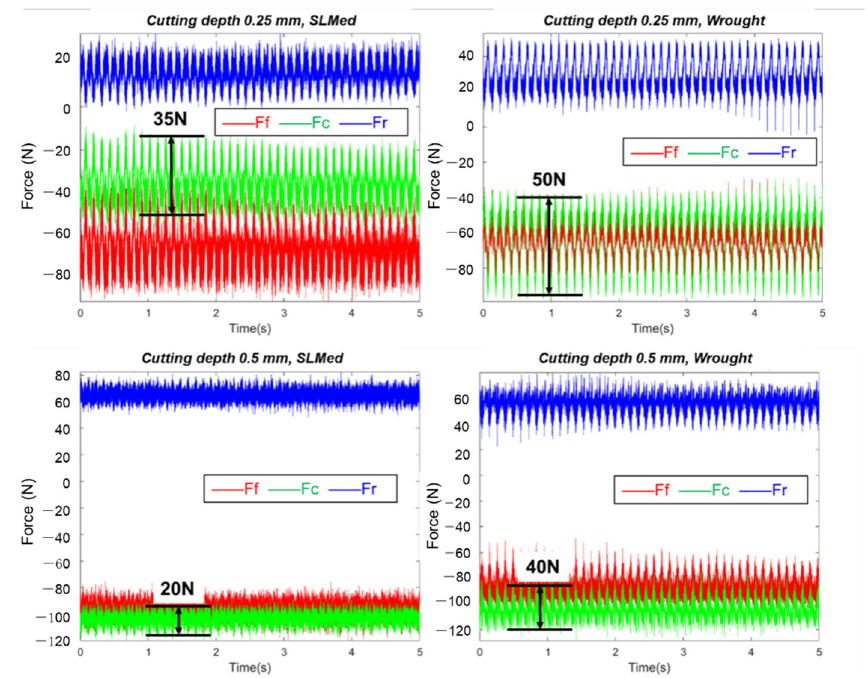
Figure 3. Cutting forces when machining wrought and SLMed Ti6Al4V workpieces at the cutting parameters of 0.1 mm/rev and 80 m/min.